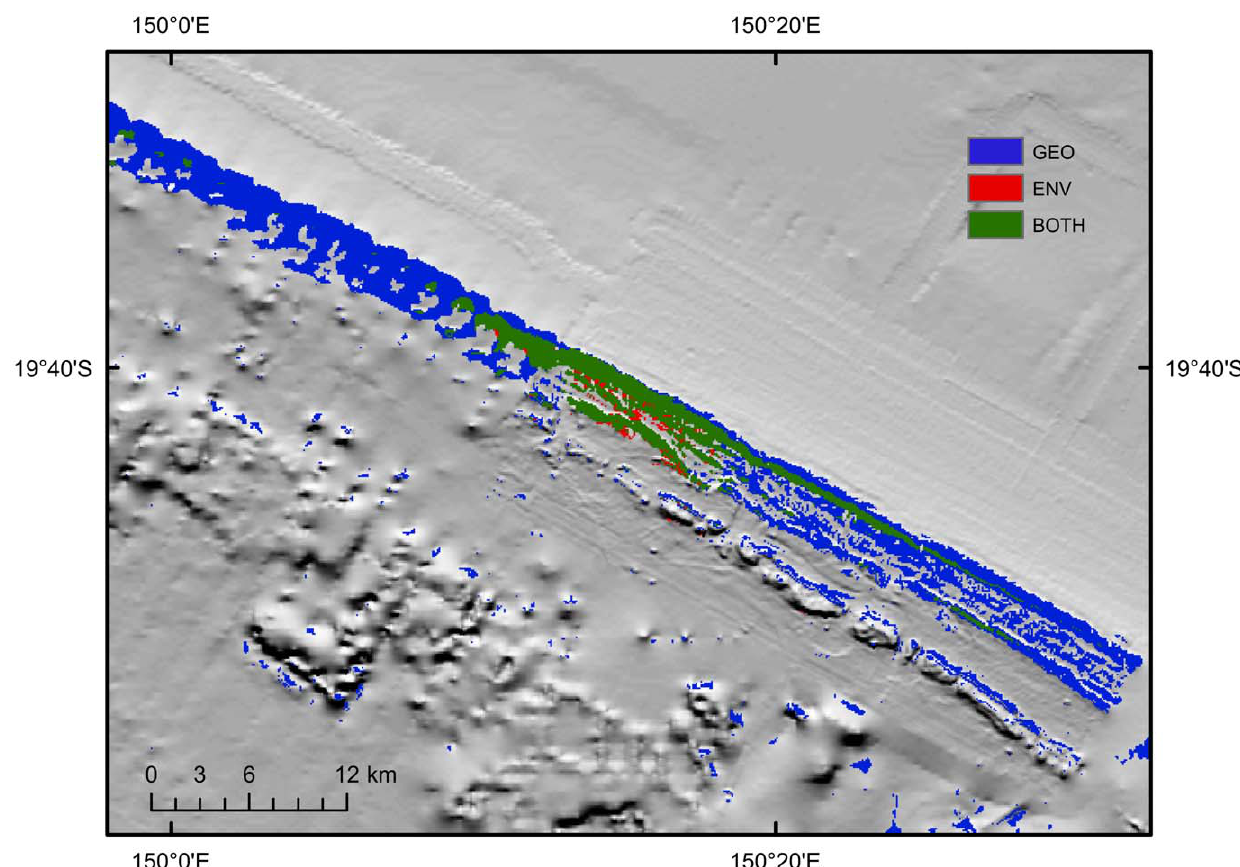
Figure 6. Predictions of heterotroph communities for the same region of Hydrographers Passage, central Great Barrier Reef. GEO models consistently predicted suitable habitat on the outer-shelf, and low suitability in shallower waters. Models using environmental data overfitted the predictions towards the location of occurrence records.